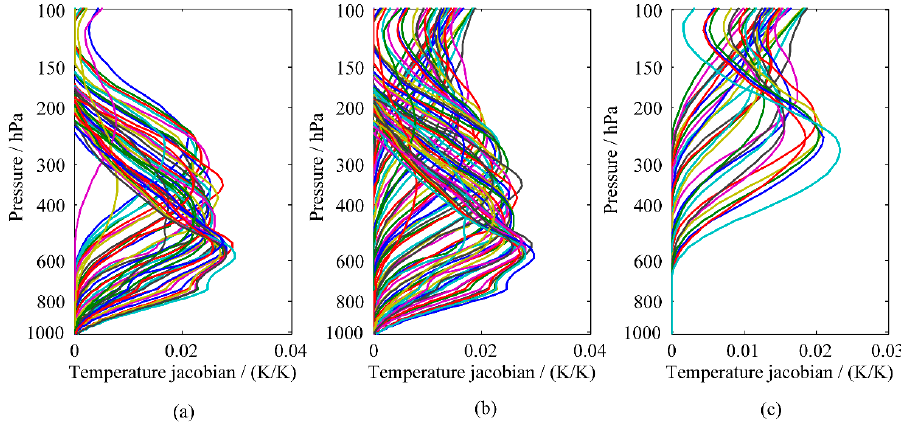
Figure 8. The temperature Jacobians of the selected temperature channels: ( a ) The selected channels of FY-4A; ( b ) The selected channels of FY-4B; ( c ) 32 selected channels that FY-4B has more than FY-4A.